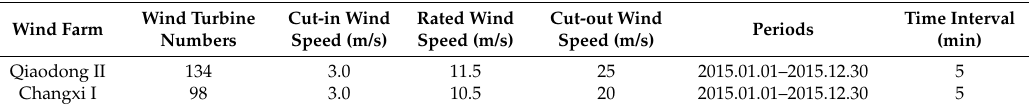
Table 2. Gansu wind farms in investigated regions.